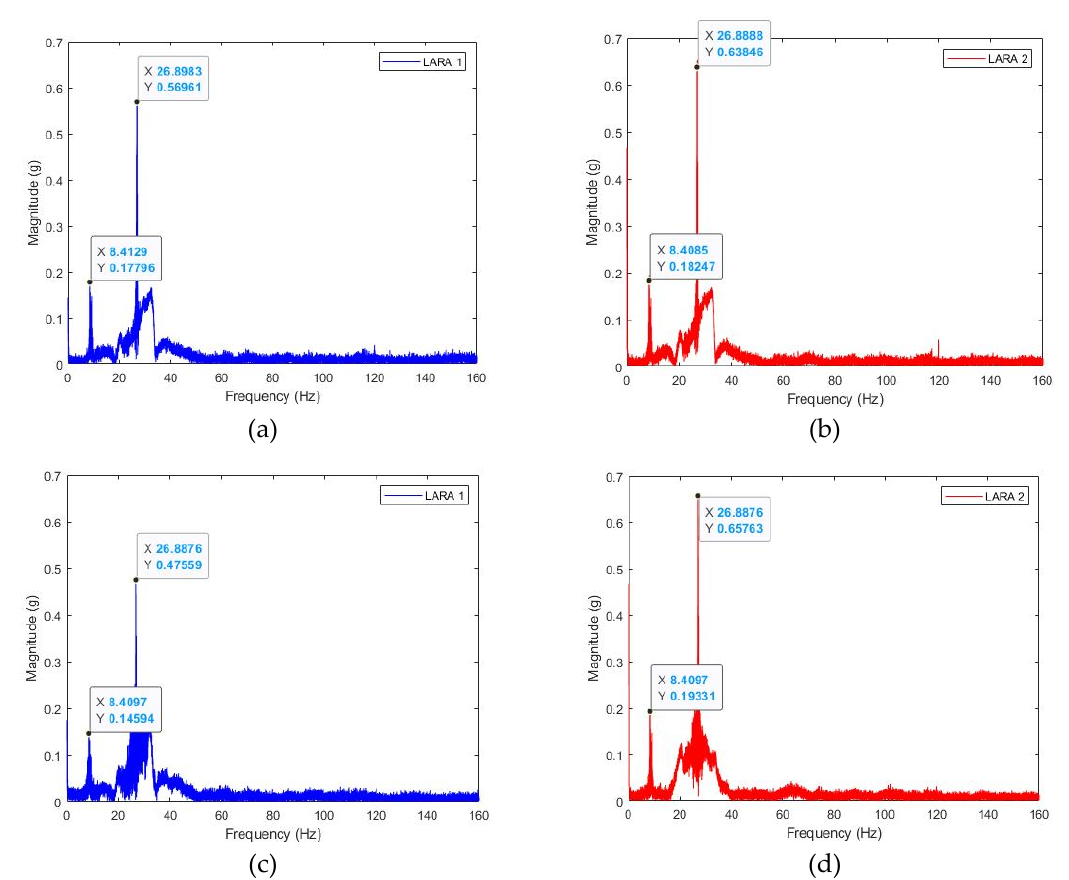
Figure 4. Eigenfrequency analysis of LARA 1 and LARA 2 located on a simply supported beam model: ( a ) LARA 1 before being resampled, ( b ) LARA 2 before being resampled, ( c ) LARA 1 after being resampled, and ( d ) LARA 2 after being resampled.